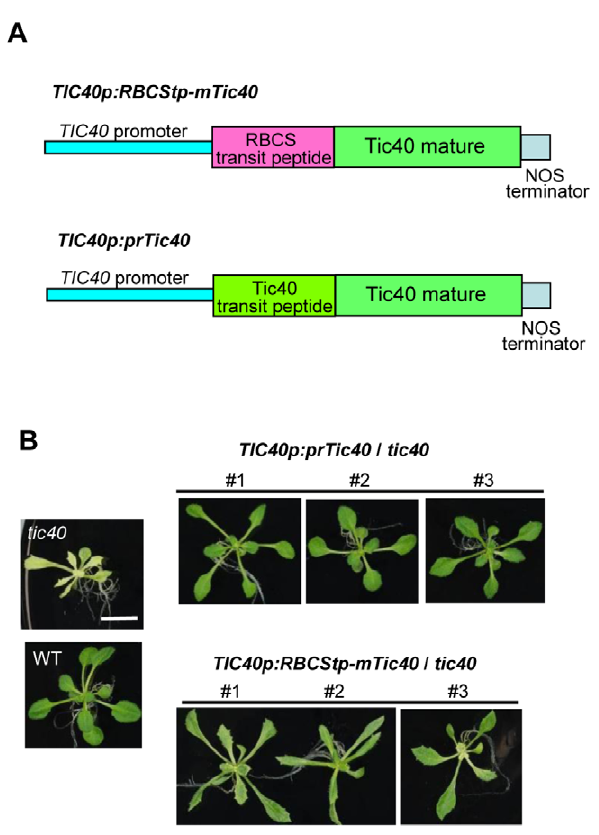
Figure 4. RBCStp-mTic40 cannot fully complement the tic40 mutant. (A) Constructs used to transform the Arabidopsis tic40 mutant. RBCStp-mTic40 or prTic40 cDNA was placed downstream of a 2-kb TIC40 native promoter. (B) Phenotypes of transgenic plants. Three indepen- dent lines are shown for each transgene. All plants were grown on MS plates for 21 d. A wild-type (WT) plant and the original tic40 mutant are shown on the left. All pictures are shown with the same magnification. Bar=1